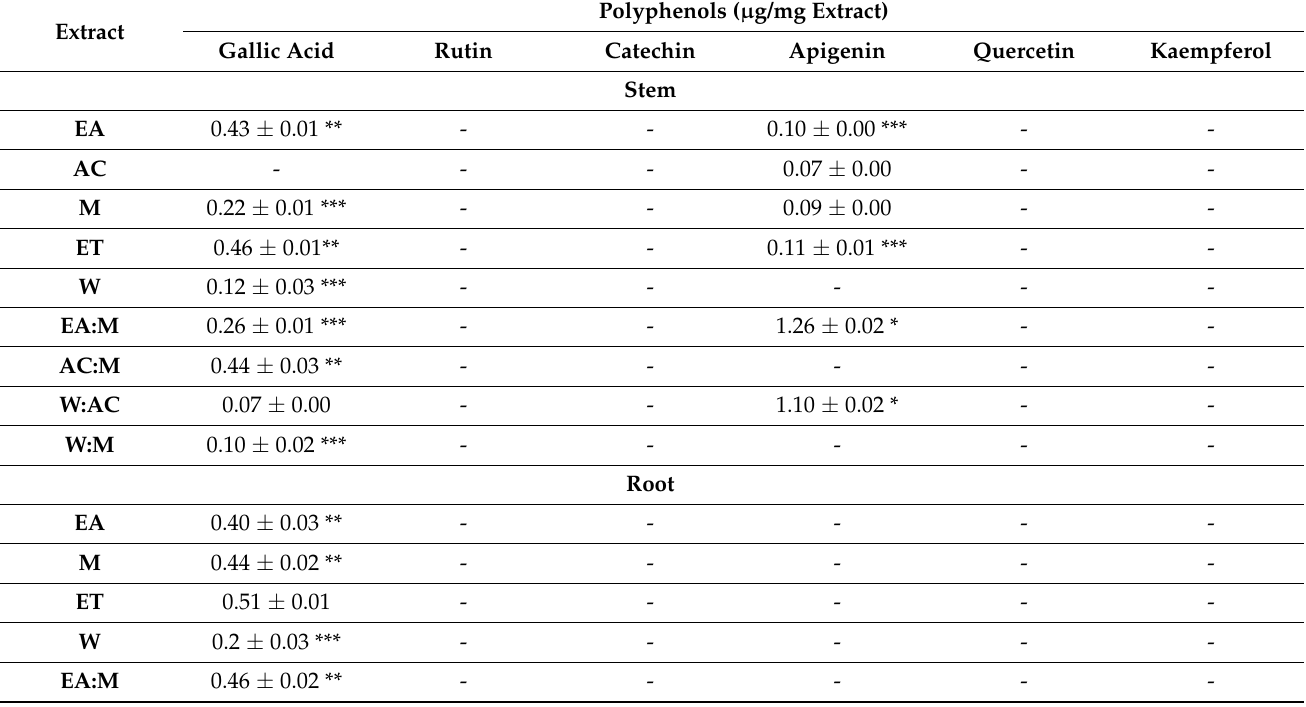
Table 2. Polyphenols identified in various solvent extracts of stem, root, seeds, and leaves of P. glabrum by HPLC-DAD